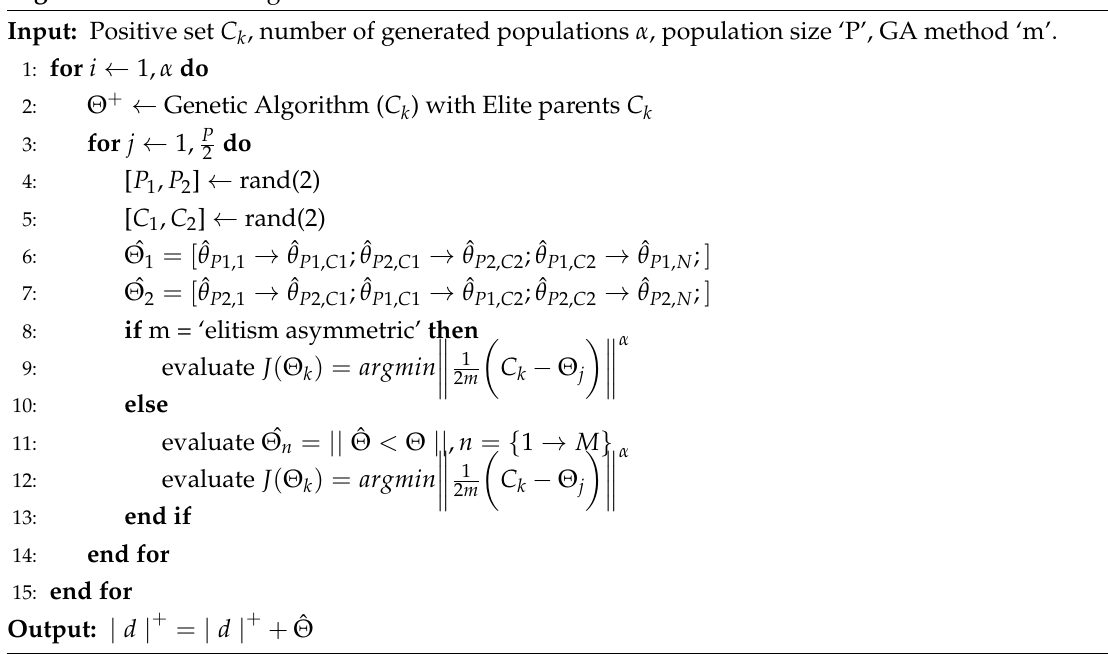
Algorithm 1 Genetic